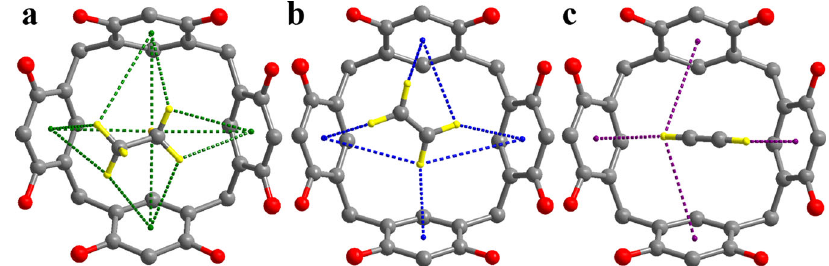
Fig. 4 Mechanism study. A comparison of preferential a C 2 H 6 , b C 2 H 4 , and c C 2 H 2 adsorption sites and close C – H··· π interactions within the calix[4] resorcinarene cavities observed by DFT-D calculations. Carbon is gray, oxygen red, and hydrogen yellow. Dashed bonds highlight C – H··· π